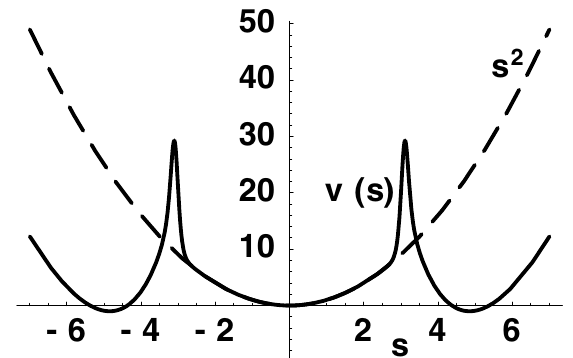
FIG. 20. The dimensionless potential for the 1D distribution of Fig. 18 (solid line), and for a harmonic oscillator (dashed